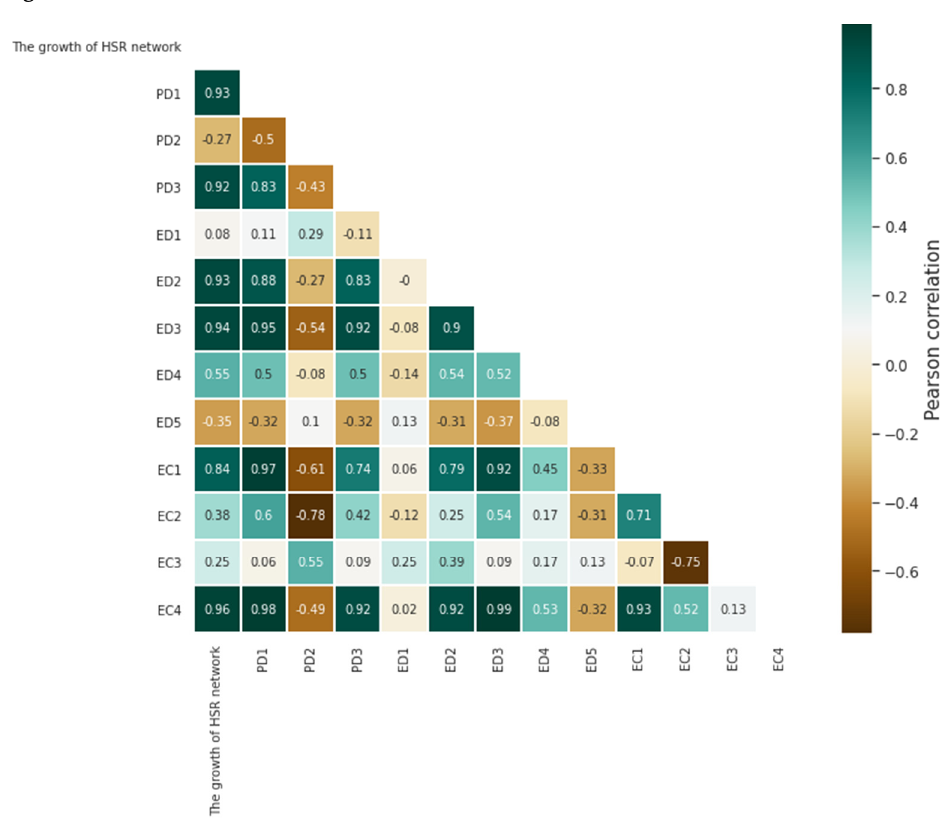
Figure 7. The PCC’s outcome of the Renfe network.